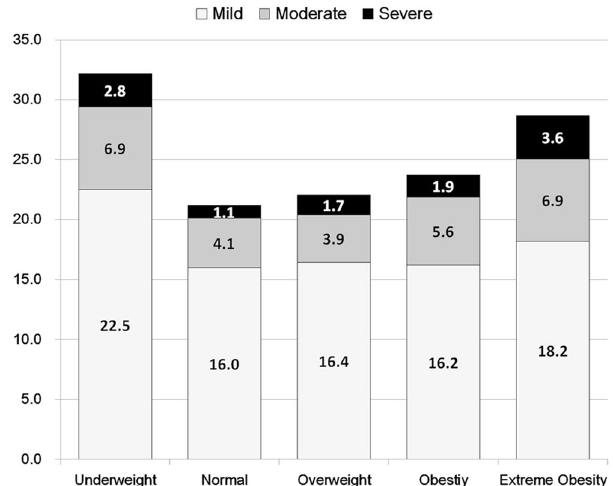
Figure 2. Relationships between prevalence (%) of tinnitus and BMI groups. We used the definition of the Western Pacific Region of the World Health Organization: underweight BMI < 18.5 kg/m 2 , normal weight 18.5 ≤ BMI < 23 kg/m 2 , overweight 23 ≤ BMI < 25 kg/m 2 , obese 25 ≤ BMI < 30 kg/m 2 , and severely obese BMI ≥ 30 kg/m 2 .